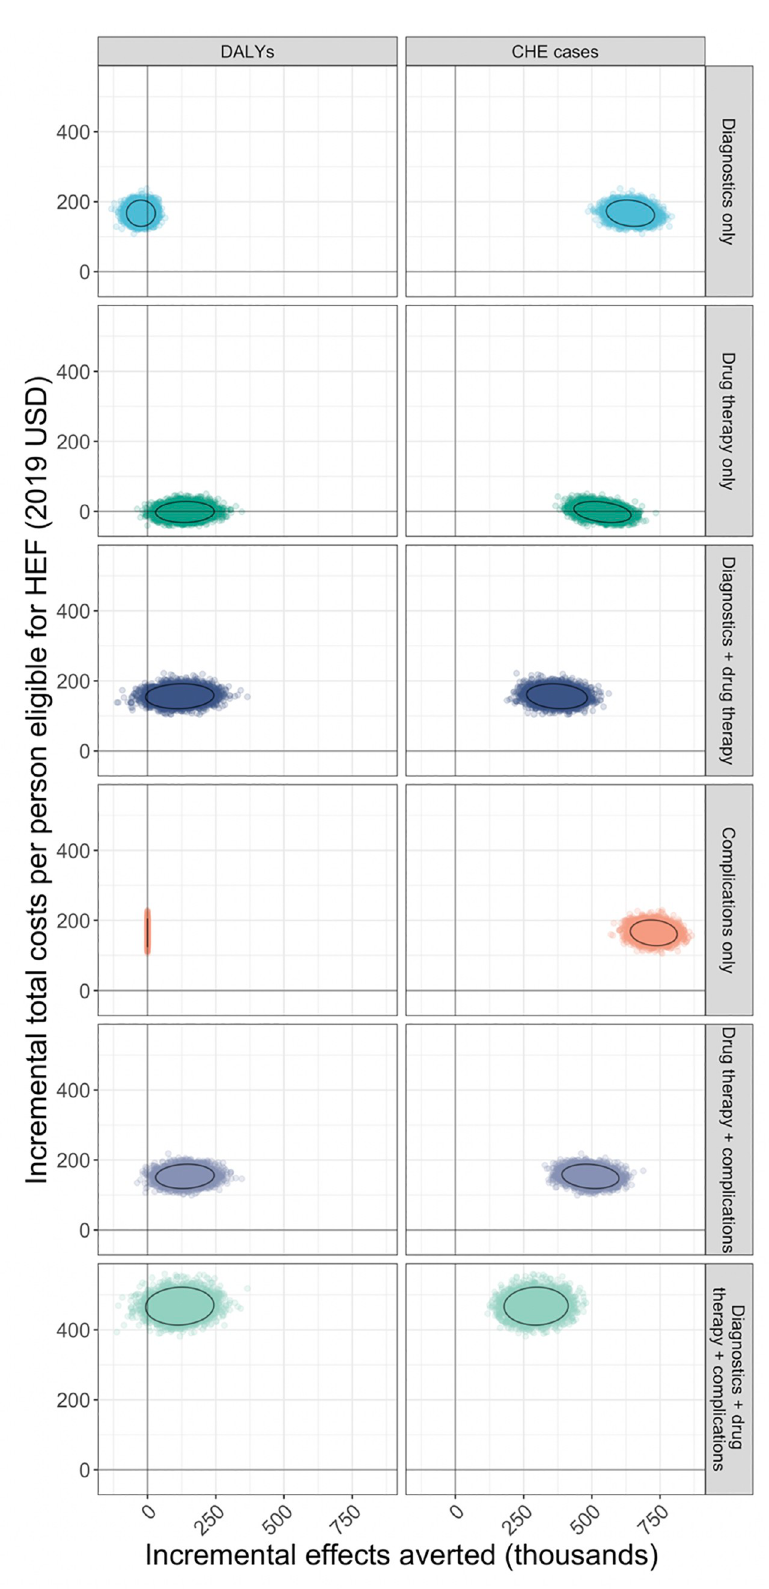
Fig 4. Results of uncertainty analysis, HEF eligibility 20%. Ellipses indicate 95% uncertainty range of estimates. https://doi.org/10.1371/journal.pone.0259628.g004 PLOS ONE | https://doi.org/10.1371/journal.pone.0259628 November5, 2021 16 /